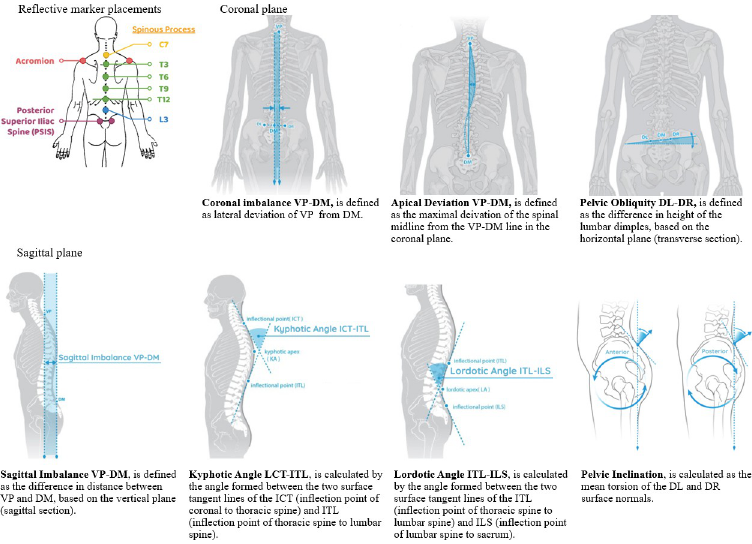
Fig 1. Reflective marker placement; Kinematic variables measured by the DIERS formetric 4D system. Abbreviations: DL: sacral dimple left; DR, sacral dimple right; DM: middle point between DL and DR; ICT: cervicothoracic transition point; ILS: lumbosacral transition point; ITL: thoracolumbar transition point; KA: kyphotic angle; LA: lordotic angle; SP: sacral point; VP: vertebral prominence.